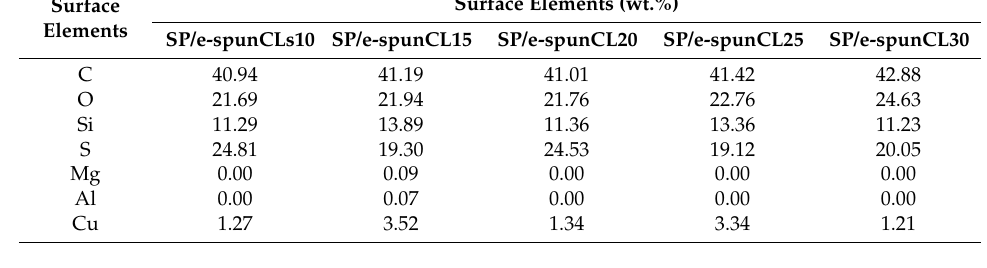
Table 3. EDX quantitative analysis of dispersion of cloisite15A in SP/e-spunCL nanocomposite membranes. Surface Elements (wt.%) Surface Elements SP/e-spunCLs10 SP/e-spunCL15 SP/e-spunCL20 SP/e-spunCL25